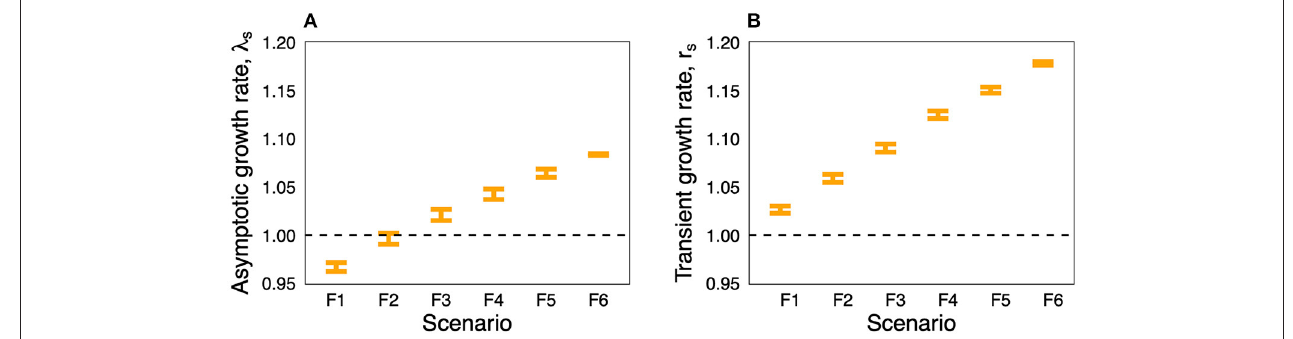
FIGURE 1 | Stochastic (A) asymptotic and (B) transient growth rates with 95% confidence intervals, calculated from 1,000 bootstrap samples. For scenario F1 (i.e., field conditions), the probability of high recruitment years was 0.17 (i.e., once every 6 years). For scenarios F2 – F6 , the probability of high recruitment increased by 0.17 for each consecutive simulation.